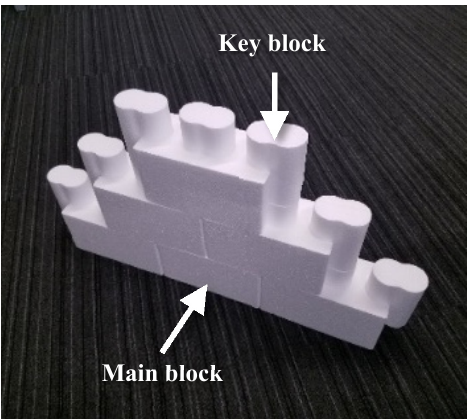
Figure 4. Construction of the peanuts-shaped block wall using styrofoam model.